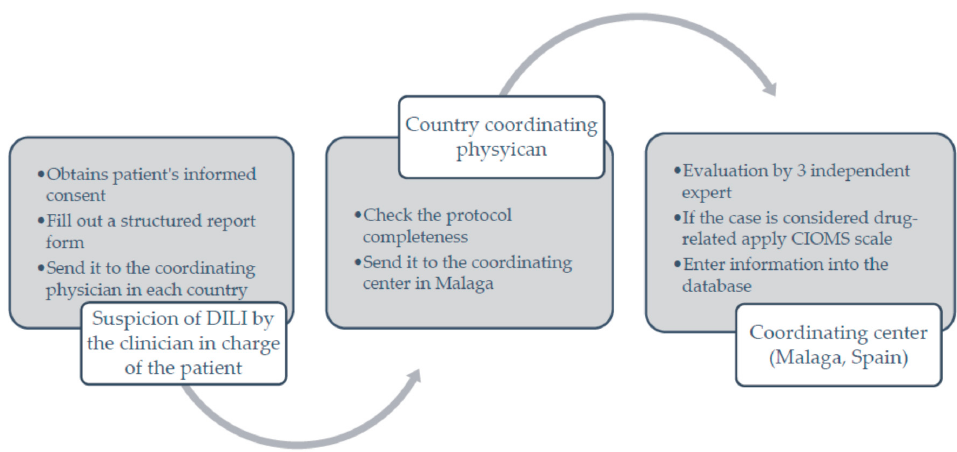
Figure 1. Flow chart depicting the process for case enrollment at the Latin-American drug induced liver injury (DILI) Network.